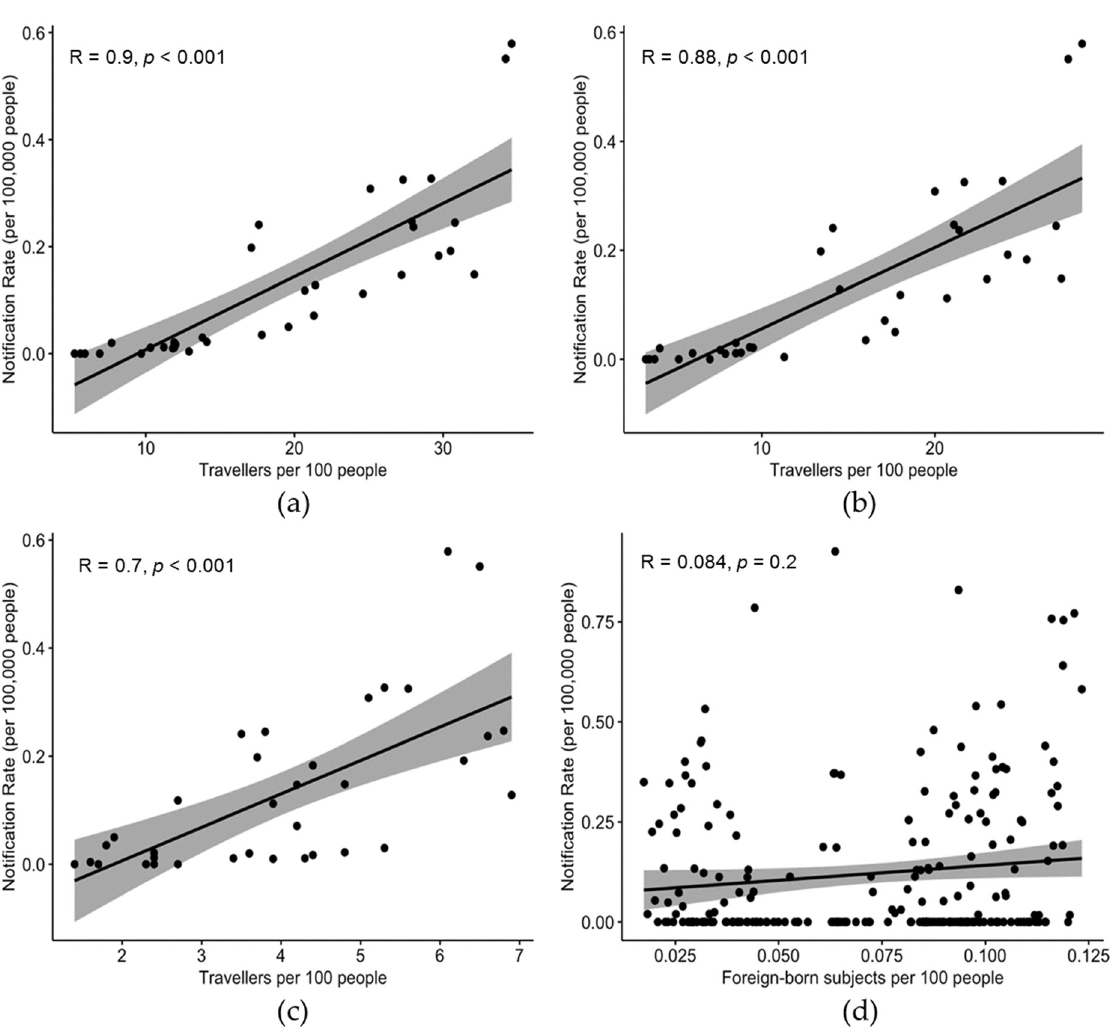
Figure 3. Correlation between notification rates (per 100,000 people) by year or reporting (2014–2020), and: the share of travelers per 100 people by geographic area (i.e., north-western, north-eastern, central, and southern Italy, and main islands), in general ( a ); including only non-work-related travel ( b ); including only work-related travel ( c ); the share of foreign-born subjects per 100 people by year and reporting region ( d ).